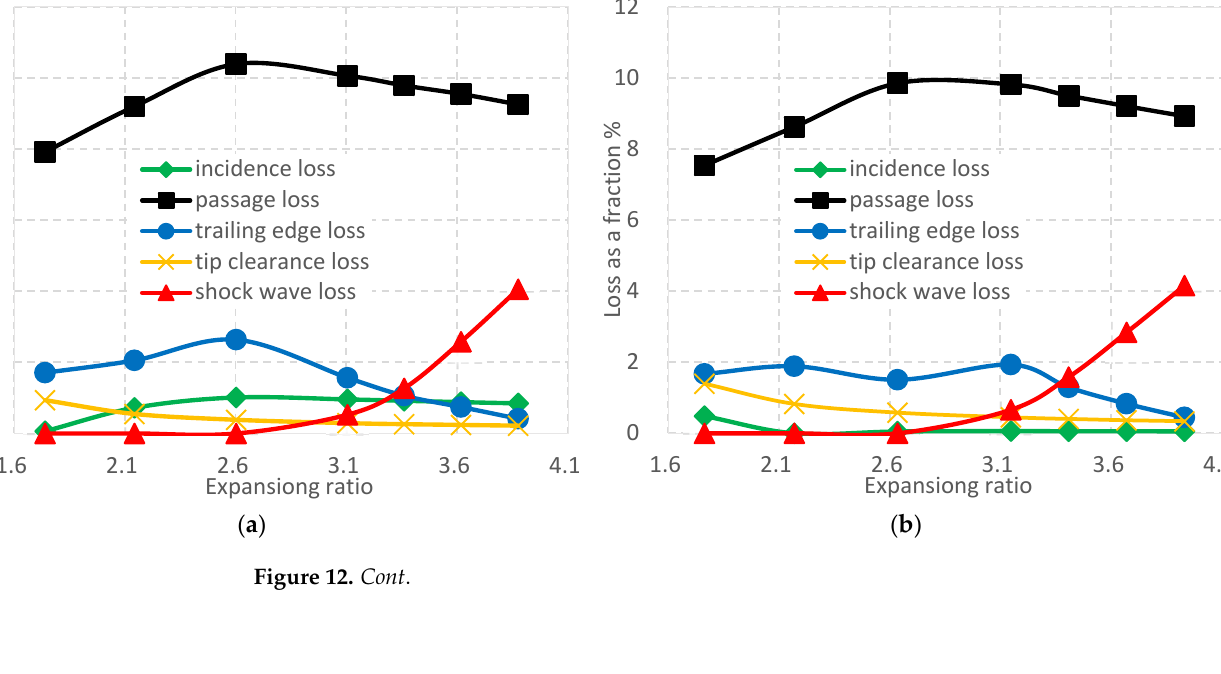
rpm. The farther away from the design speed, the greater the incidence loss. Trailing edge loss increases first then decreases with the increase in the expansion ratio. There is no shock wave does not occur when the Mach number is below unity. When the expansion ratio is up to 2.6, the turbine starts to work in transonic conditions, and the shock wave the expansion ratio increases further, the shock wave becomes stronger and stronger, and the shock wave ‐ induced loss increases rapidly. Figure 11. The error of the predicted efficiency and the CFD efficiency. Figure 11. The error of the predicted efficiency and the CFD efficiency.